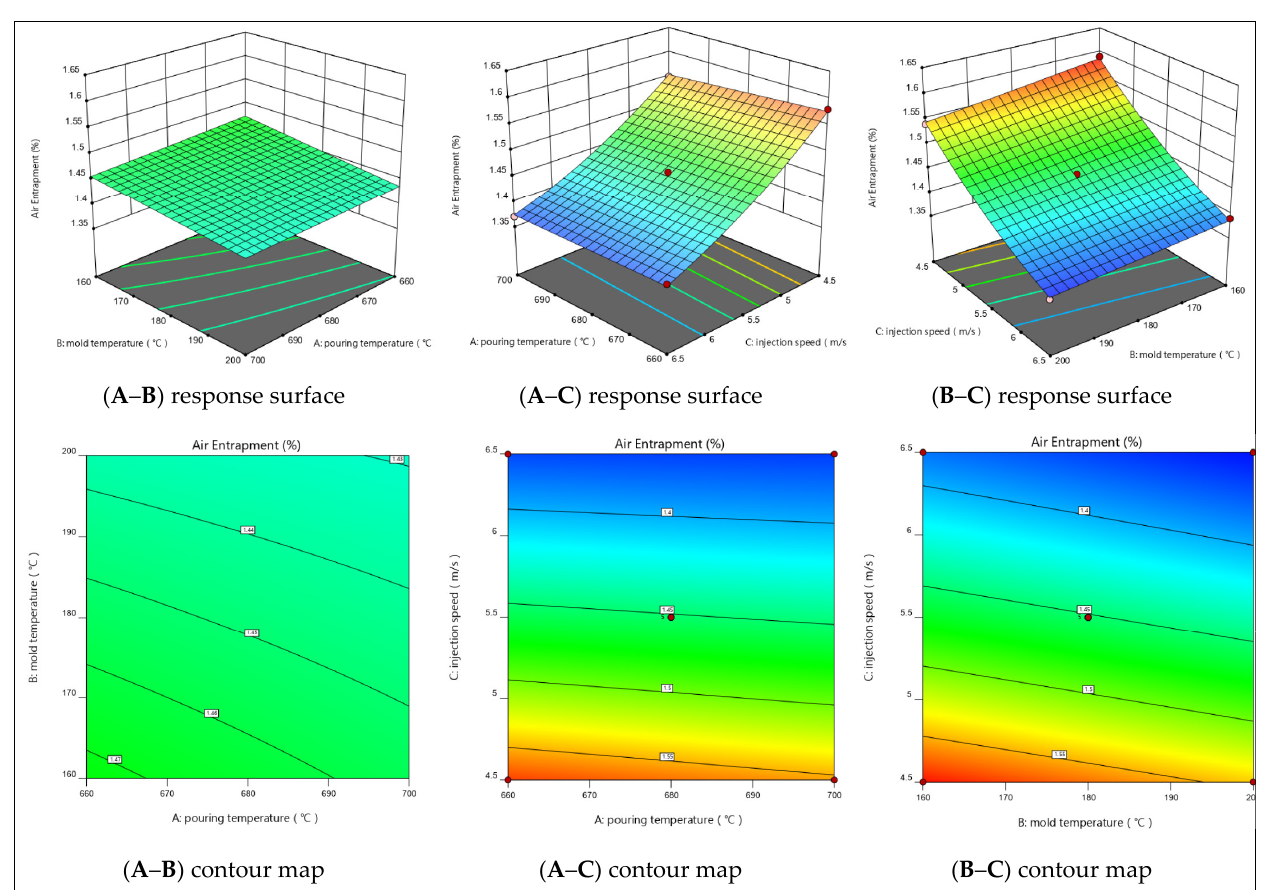
Figure 5. The interaction effect of two factors on the air entrapment rate (Y 1 ).